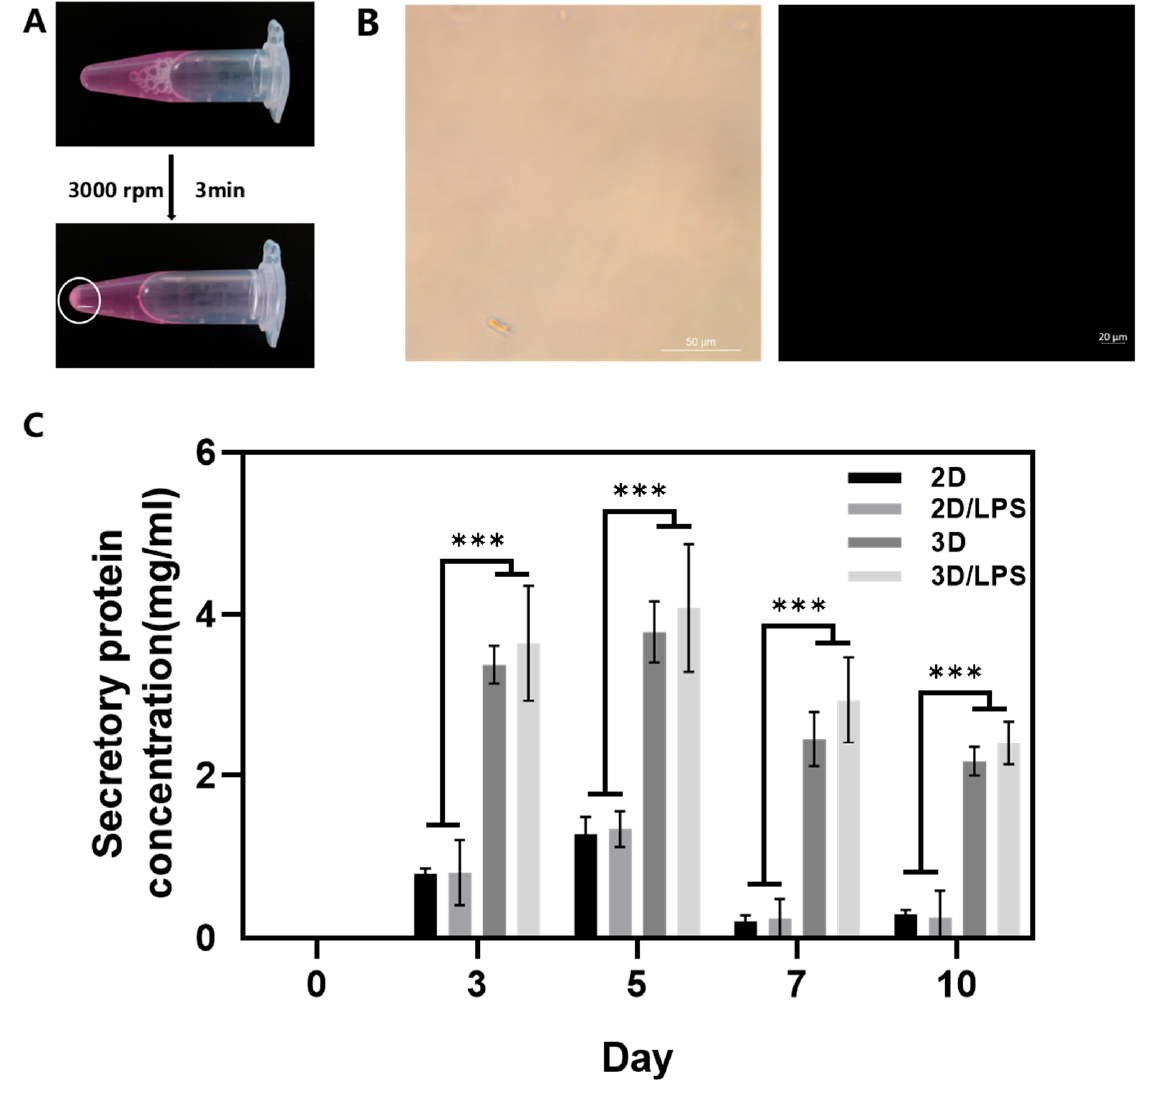
Figure 6. Collection and protein concentration measurement of secretome. ( A ) Separation of PDLSCs and SupraGel by adding PBS and centrifugation; white circle shows cell deposits. ( B ) Images of the supernatant after centrifugation. Left: light microscope image; scale bar—50 µ m; Right: Live/Dead image; scale bar—20 µm. ( C ) Secretory protein concentration of 2D-, 2D/LPS-, 3D- and 3D/LPS-group-derived secretome on days 0, 3, 5, 7 and 10. *** p < 0.001.